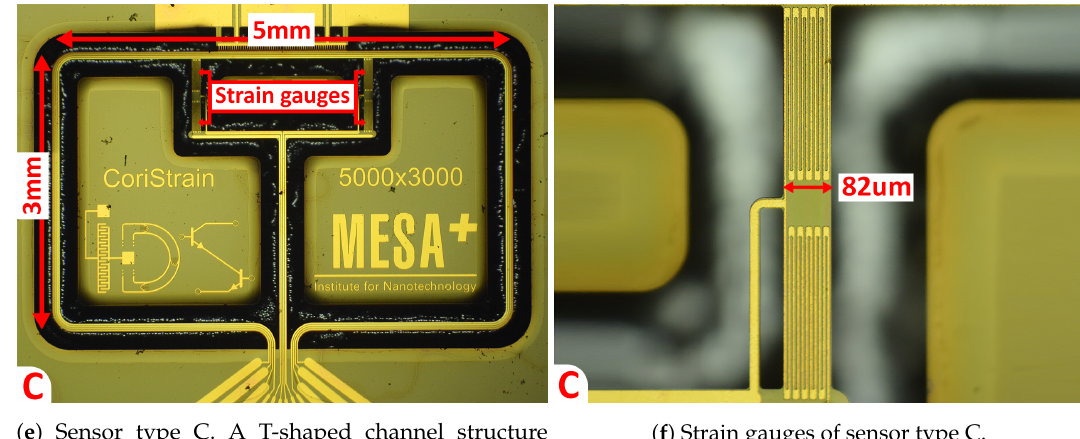
Figure 10. Microscope images of the three sensor types. Strain gauges and reference resistors are indicated in the subfigures. The metal tracks of the gauges are 4 µm wide. The mask design of the strain gauges and reference resistors are